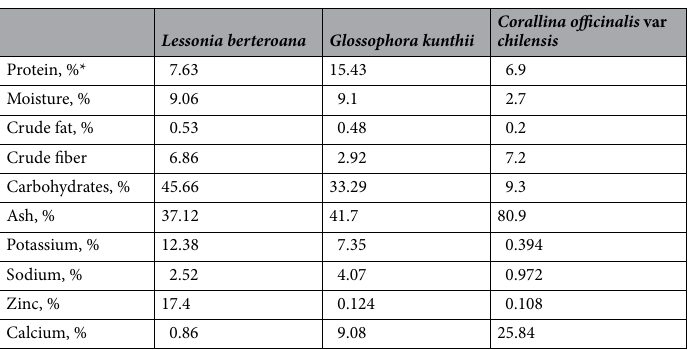
Table 3. Nutritional composition of the main categories identified in the diet of adult Acha fish ( Medialuna ancietae ). Results (except moisture) are expressed on a "dry matter" basis. *Kjeldahl crude protein = % N ×